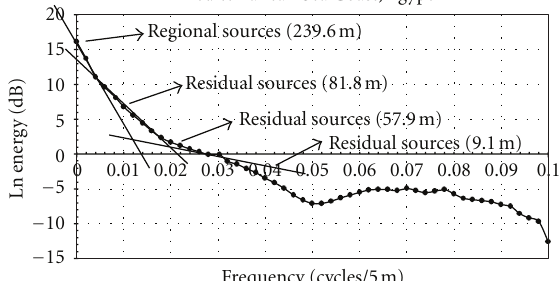
Figure 4: The local power spectrum of the ground magnetic data for the study